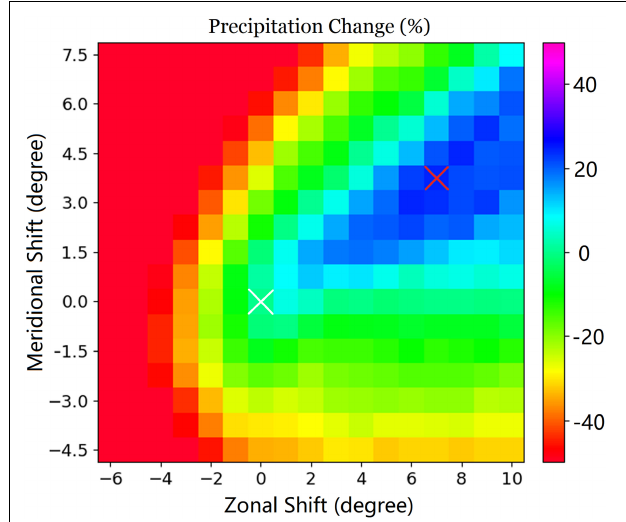
FIGURE 3 | Mean relative changes in the regionally averaged maximum 72-h precipitation during the selected extreme precipitation events over Metro Vancouver for the simulations with different LBC shifting relative to the historical simulations. White cross indicates the historical simulations (no LBC shifts) and red cross indicates the mean LBC shifts corresponding with the maximum precipitation increase.